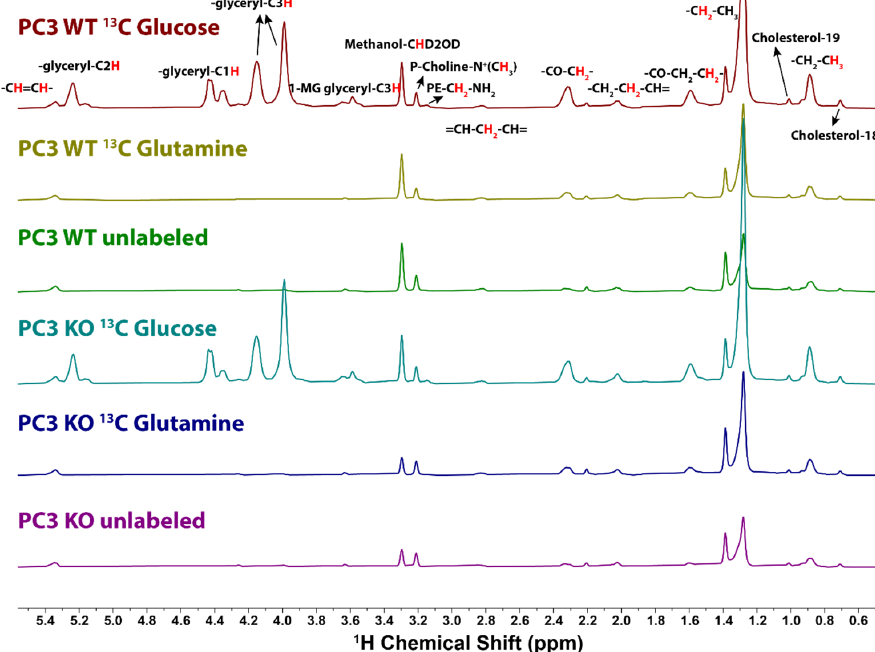
Figure 3. 1D 1 H{ 13 C}-HSQC spectra of the lipid extracts from WT or KO PC3 cells cultured in [U- 13 C]-glucose, [U- 13 C]-glutamine, or no tracer. The spectra were recorded with 13 C adiabatic decoupling during the acquisition time of 0.25 s for 1024 scans (34 min acquisition). The spectral width was set at 12 ppm the same as the proton spectrum and recycle delay was set to 1.75 s. A total of 1796 data points were collected and zero filled to 4096 points with a 4 Hz line-broadening exponential. [U- 13 C]-Glucose tracer samples in both cell types showed 13 C incorporation into various functional groups, with glycerol backbones as the most heavily labeled groups. In contrast, [U- 13 C]-glutamine labeled samples only showed incorporation mainly into bulk acyl-chains as well as C2, C3 positions on the fatty acids, indicating the main contribution of de novo fatty acid synthesis. The 1D HSQC spectra shown are normalized to cell